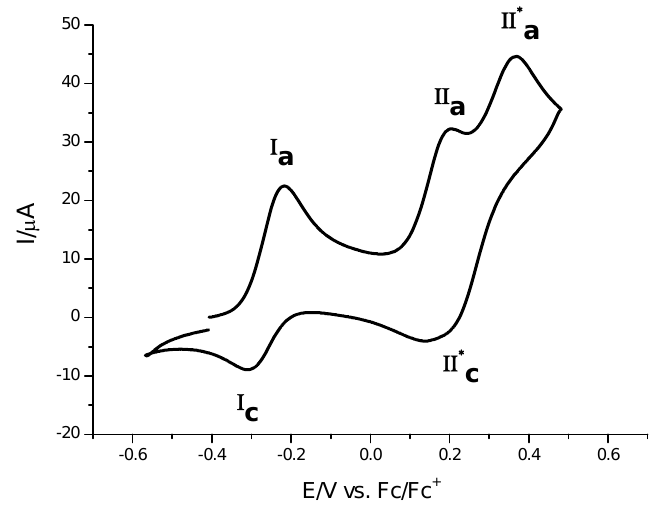
Figure 6. Cyclic voltammograms obtained for 10a in the presence of 0.1 M TBABF acetonitrile. Scan rate 0.5 V s − 1 . The scan potential was initiated from E direction. The working electrode used was a platinum disc.